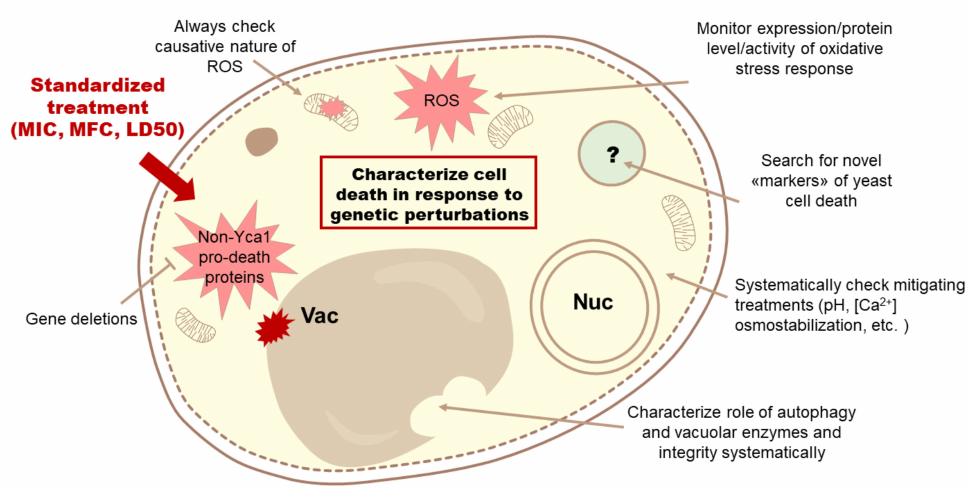
Figure 6. Recommendations for improving future cell death studies in